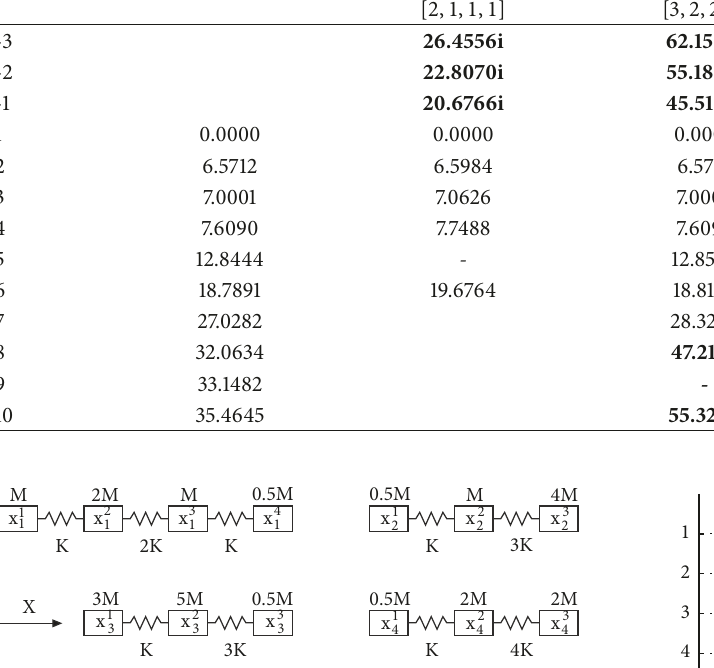
Figure 2: Mathematically partitioned four substructures; the local DOFs are labeled in the box.